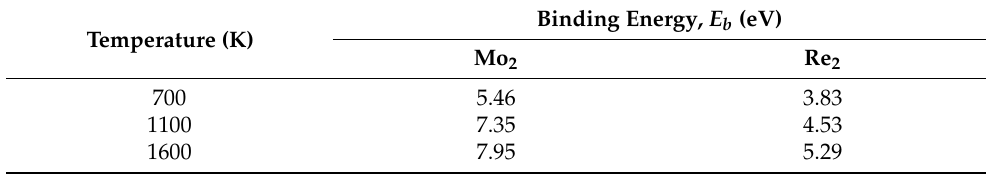
Table 1. Biding energy of Mo 2 and Re 2 dimers at different